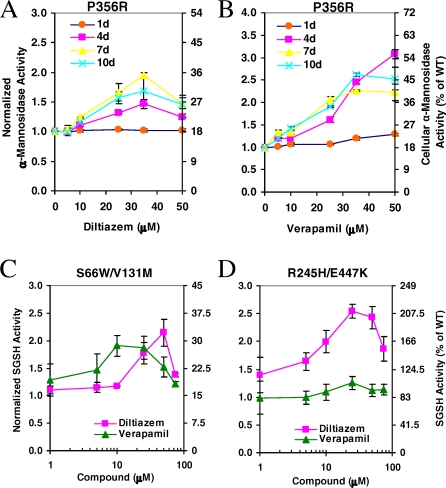
The Influence of Diltiazem and Verapamil on Mutant α-Mannosidase and Heparan Sulfate Sulfamidase (SGSH) Activity in Patient-Derived FibroblastsThe enzyme activity of treated cells was normalized against that of untreated cells of the same type (left y-axis) and expressed as the percentage of WT enzyme activity (right y-axis).(A) The influence of diltiazem on P356R α-mannosidase activity after culturing for 1 d (black line), 4 d (pink line), 7 d (blue line), and 10 d (yellow line).(B) The influence of verapamil on P356R α-mannosidase activity after culturing for 1 d (black line), 4 d (pink line), 7 d (blue line), and 10 d (yellow line).(C) The influence of diltiazem (pink line) and verapamil (green line) on S66W/V131M SGSH activity after culturing for 5 d.(D) The influence of diltiazem (pink line) and verapamil (green line) on R245H/E447K SGSH activity after culturing for 5 d, respectively. Unlike in Figure 1 and 3, percent activity relative to WT in Figure 5C and 5D is calculated from the specific activity of S66W and R245H reported in the literature [27].